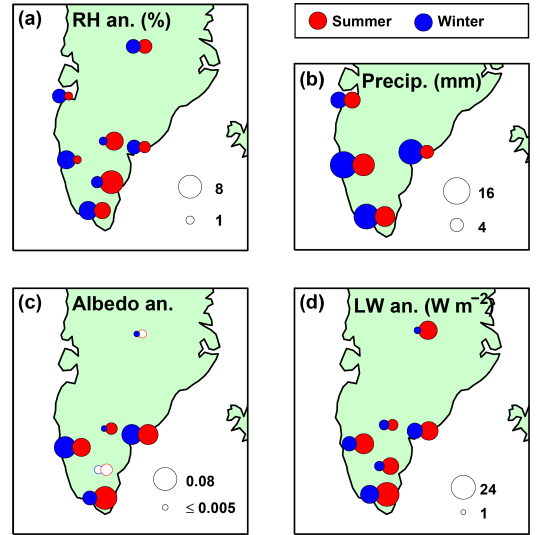
Figure 5. Composites of (a) the relative humidity anomaly, (b) total precipitation (in millimeters of liquid water) and (c) the albedo and (d) longwave radiation anomalies (positive downward), obtained from weather stations. Precipitation is summed over the days 0 to 2 of the events (days 1 to 3 for Station East). Relative humidity and longwave radiation are averaged from day 0 to 2 and the albedo from day 1 to 3 (again 1 day later for Station East). All anomalies are with respect to the week before the events. Filled circles in c indicate that albedo decreases, empty ones indicate increases. Un- certainty estimates are provided in Table